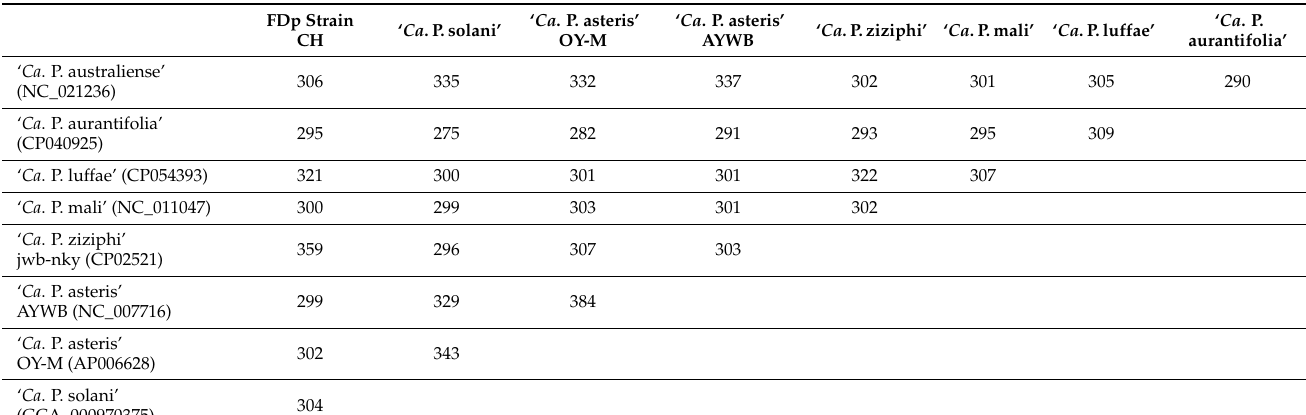
Table 3. Pairwise genome